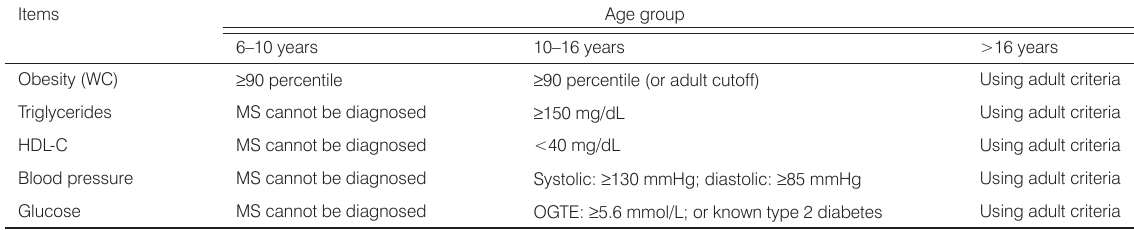
Table 3. IDF definition of MS in adolescents and